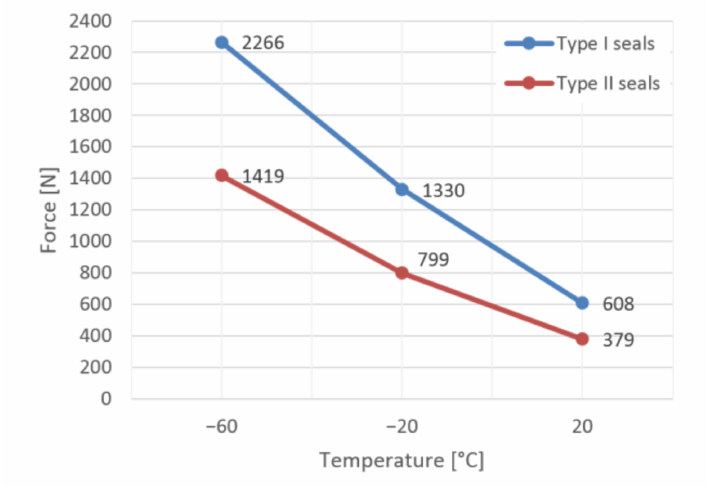
Figure 19. Closing force vs. temperature dependency for Type I and Type II seals–piston with a conical shape.